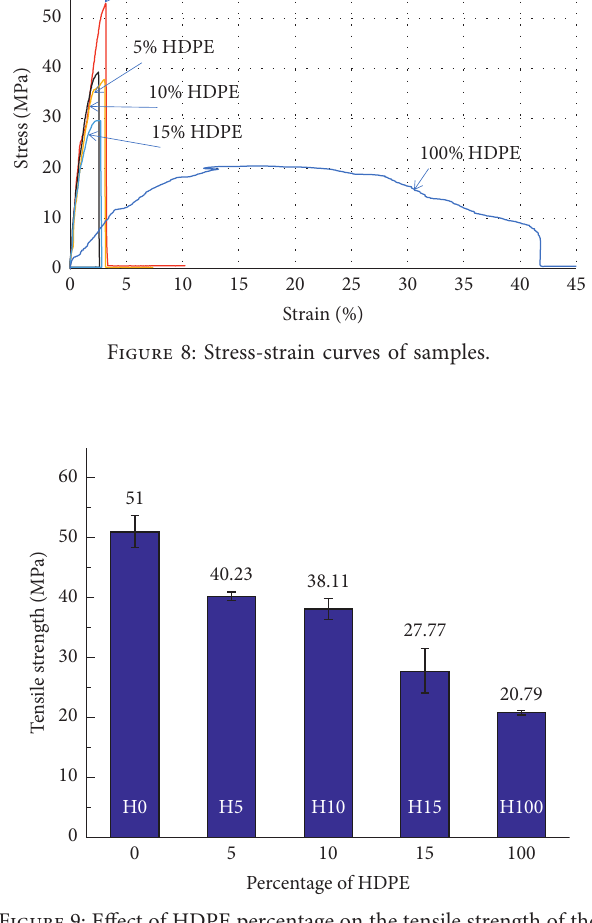
Figure 9: Effect of HDPE percentage on the tensile strength of the PBT/HDPE blends.